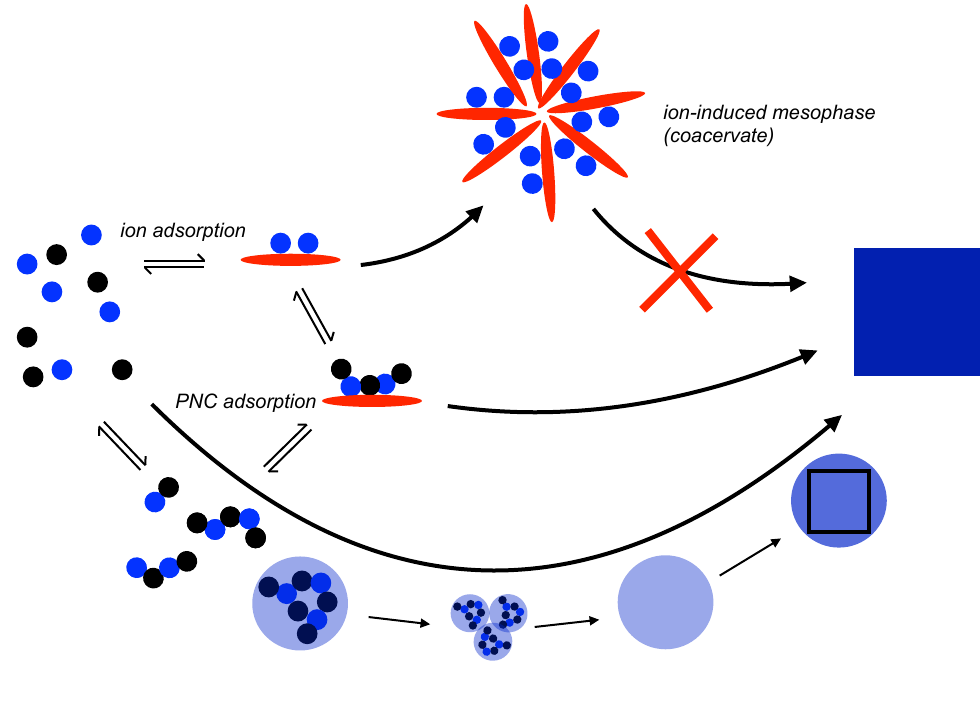
Figure 2. Schematic illustration of the mechanism of nucleation according to the PNC pathway (bottom, cf. Figure 1) with potential effects of ion (top) and PNC (middle) adsorption by an additive (red ellipsoid). For strong ion-additive interactions and/or high additive concentrations, the formation of coacervates is expected (if the additive chemistry and structure allows), which inhibit mineral formation entirely. Corresponding size regimes span the whole colloidal domain depending on the type of mesophase formed [27]. For weaker ion-additive interactions and/or low additive concentrations, PNC binding by the additive (middle) becomes probable, and the process can proceed toward particle formation. Possibilities for additive control during the latter process are discussed in more detail in Section 3.2, also see Figure 3. For explanation see the